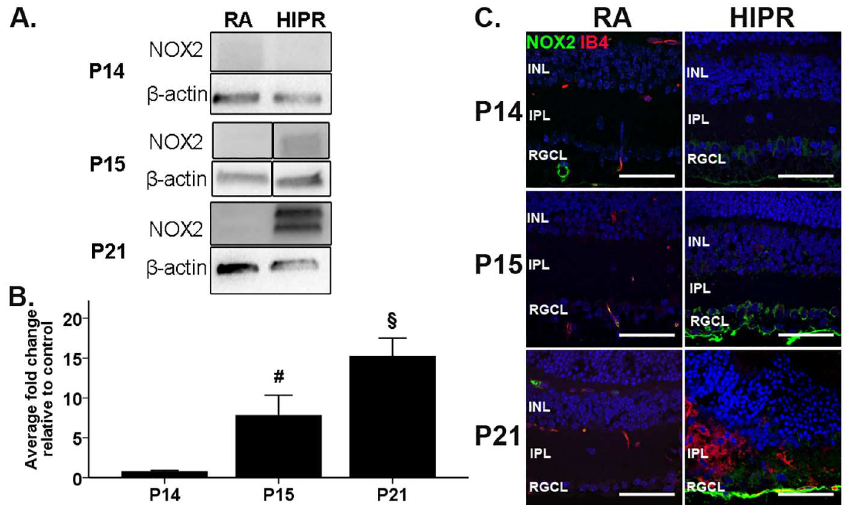
Fig 5. Increased NOX2 expression in hyperoxia-induced proliferative retinopathy. (A, B) RetinalNOX2 was evaluatedby western blotting, quantifiedby densitometry, and normalized to β -actin. (A) Representative western blots are shown. The vertical black line indicatesseparatesamples were run betweenthese lanes on the same blot. (B) Quantification of westerns show that NOX2 levels significantly increasedfrom P14 to P15 and from P15 to P21. Data were fold change ± SEM (n (cid:21) 5 per group). * p < 0.05HIPR to respectiveage- matched RA controls. § p < 0.05HIPR P21 comparedto HIPR P15. (C) Retinalcross sections were immunostained with NOX2 (green), IB4 (red), and counterstained with DAPI (blue, N = 3). In RA, NOX2 was only seen in blood vessels. In HIPR, NOX2 was observed in the retinal ganglioncell layer. Scale bar, 50 μ m. INL, inner nuclear layer. IPL, inner plexiform layer. RGCL, retinal ganglioncell